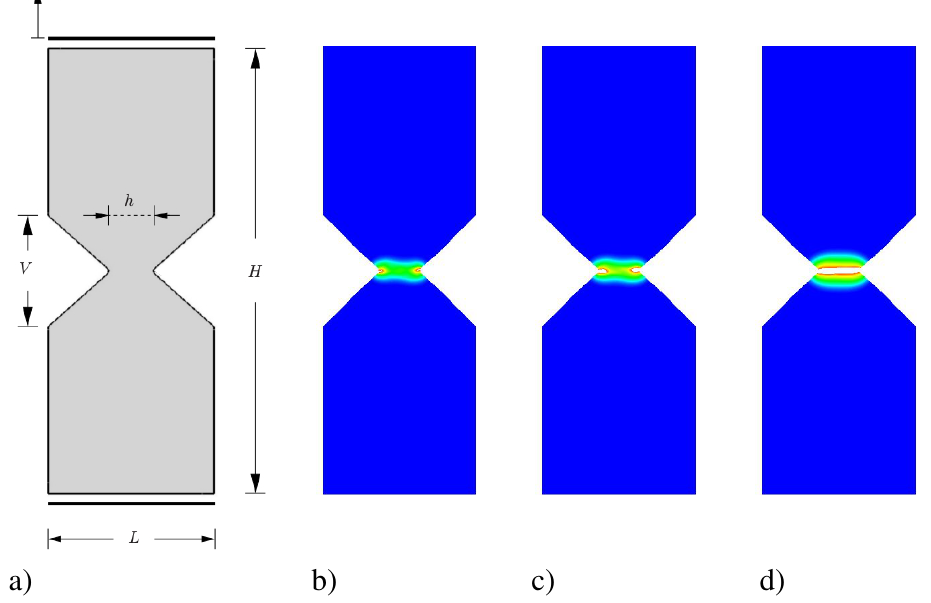
Figure 12. V-notch bar in tension. ( a ) Geometry and boundary conditions. ( b – d ) FEM: Contour plots of the fracture phase-field d evolution for different loading states up to final